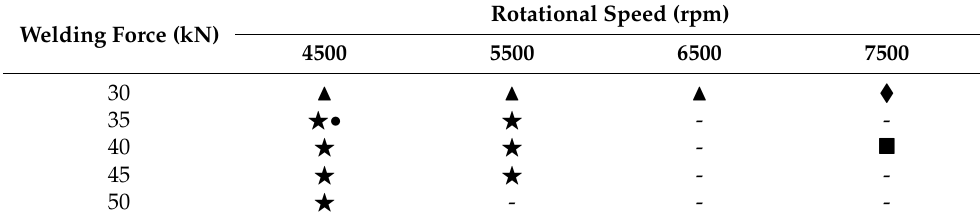
Table 3. Weld quality of FPW joints.